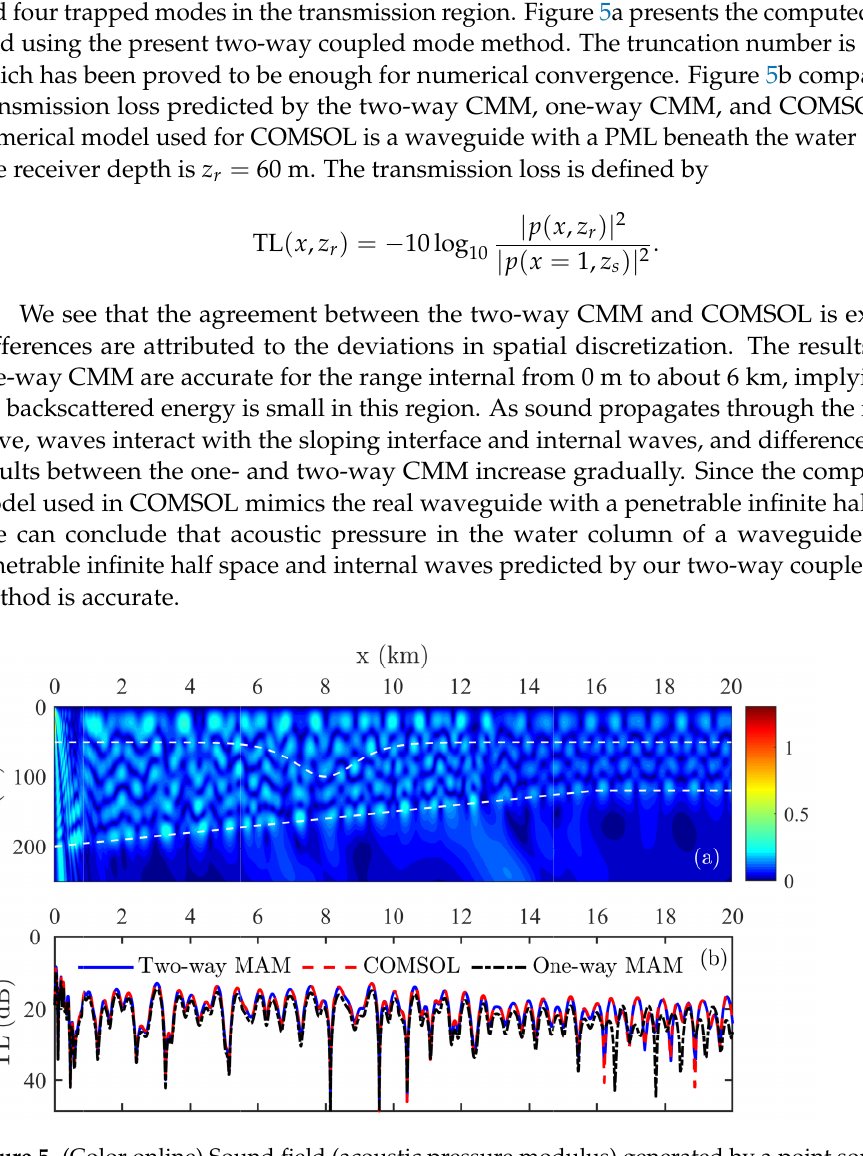
Figure 5. (Color online) Sound field (acoustic pressure modulus) generated by a point source in a waveguide with a penetrable infinite half space and an internal wave. ( a ) Sound field computed by the present two-way coupled mode method with N = 30. ( b ) Transmission loss versus range predicted using the present two-way coupled mode method, one-way coupled mode method, and COMSOL. The point source is located at ( 0,30 ) m. The frequency is